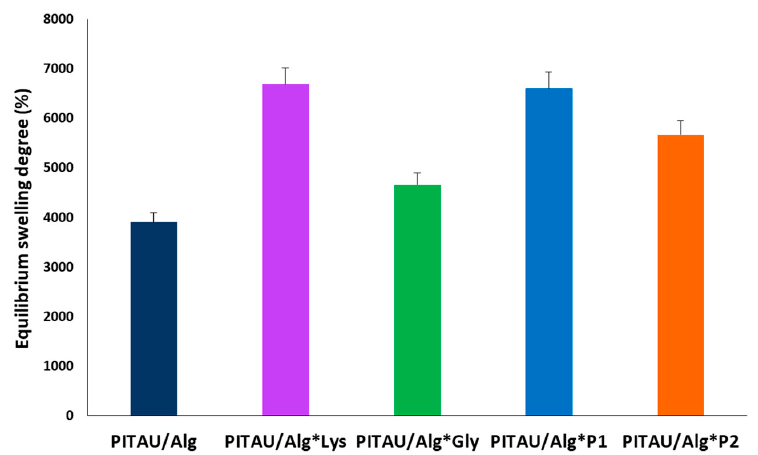
Figure 8. Equilibrium swelling degree of PITAU/Alg and DN hydrogels.